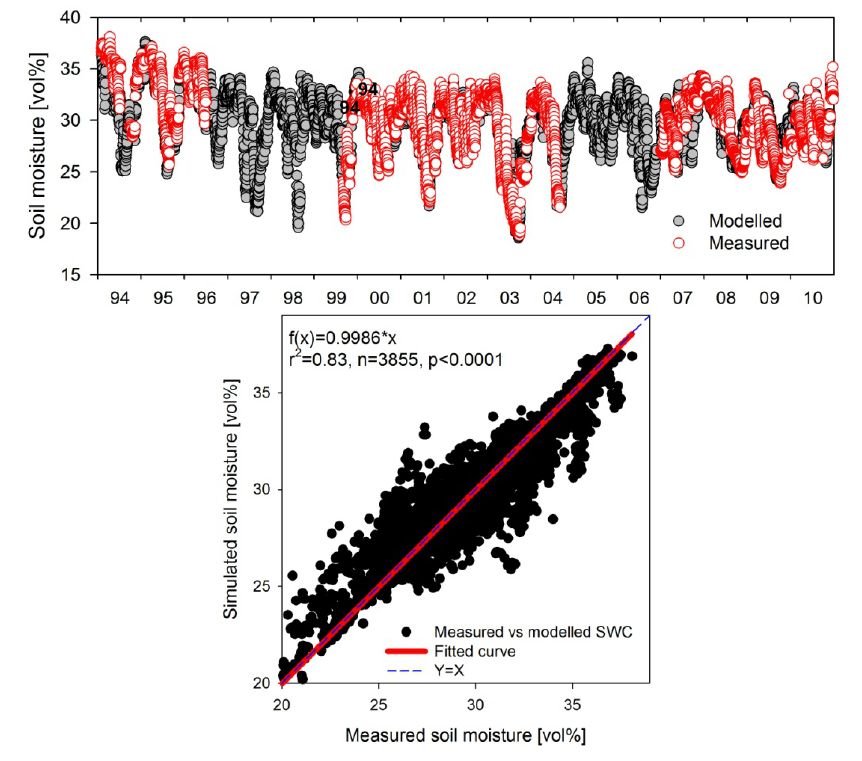
Fig. 1. Comparison of measured and modeled values of volumetric water content at 10cm depth from 1994 to 2010. Simulation of soil Figure 1. Comparison of measured and modeled values of volumetric water content at 10 cm 2 volumetric water content was done using a support vector machine modeling depth from 1994 to 2010. Simulation of soil volumetric water content was done using a 3 support vector machine modeling approach. 4